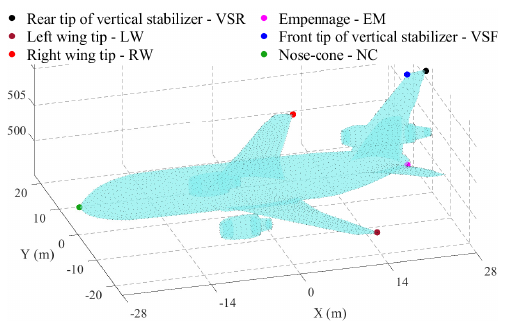
Figure 9. Aircraft orientation used in simulation and obtained inception points of connecting leaders from aircraft